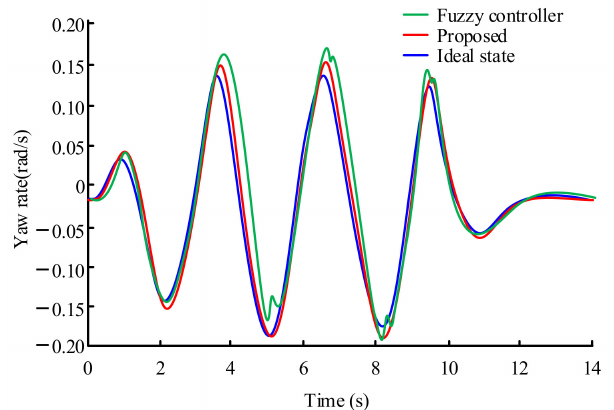
Figure 5. Difference in yaw rate regulation under serpentine